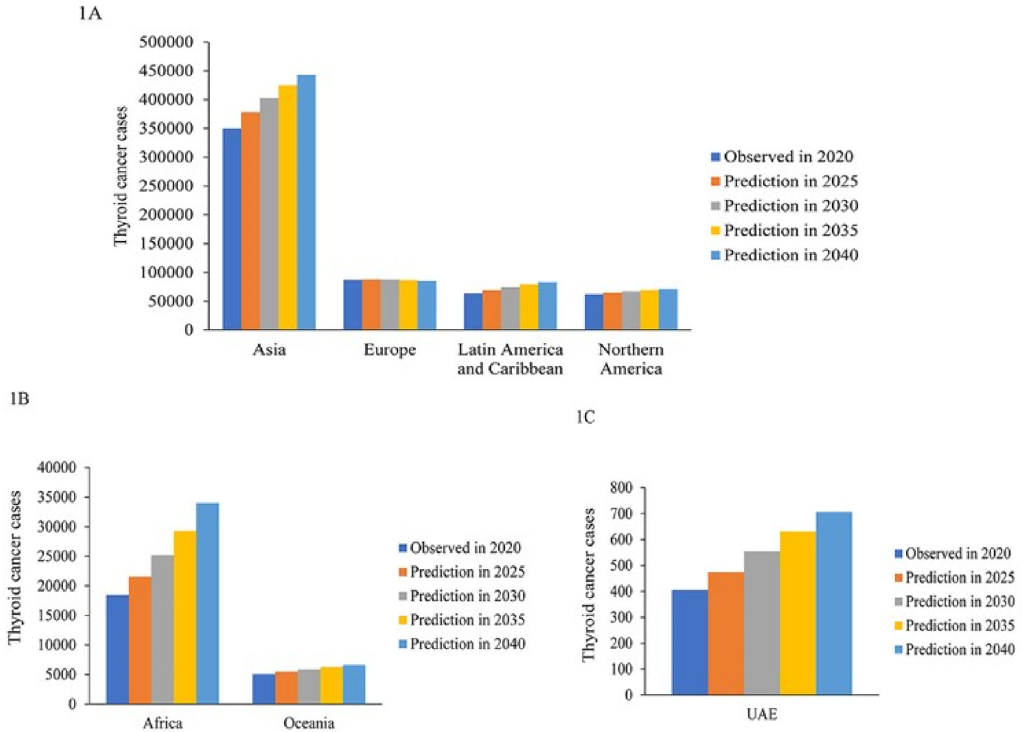
Figure1.GlobalthyroidcancerdemographicsusingthepredictivemodelbasedonGLOBOCANdatafrom2020 to